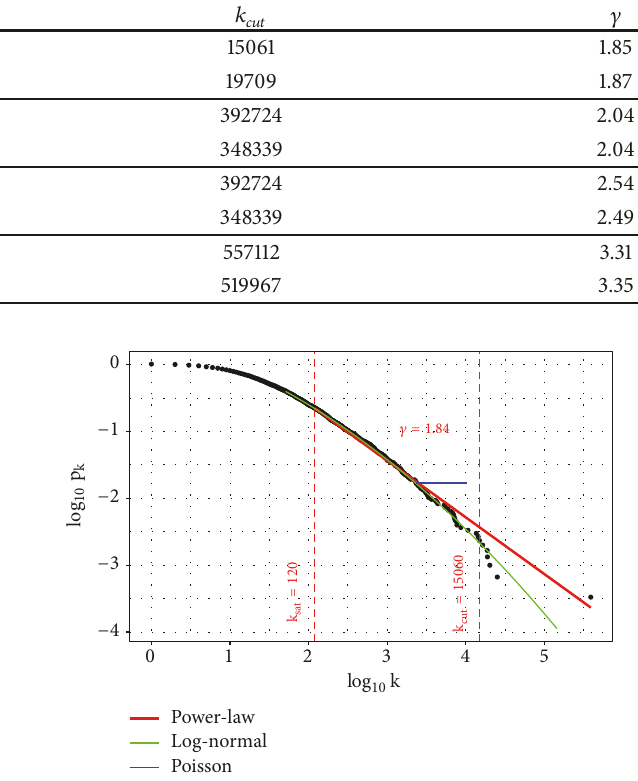
Figure 11: Distribution of the 𝑘 [1,𝑖𝑛] 𝑗 edges at the LAU 2 settlement hierarchy